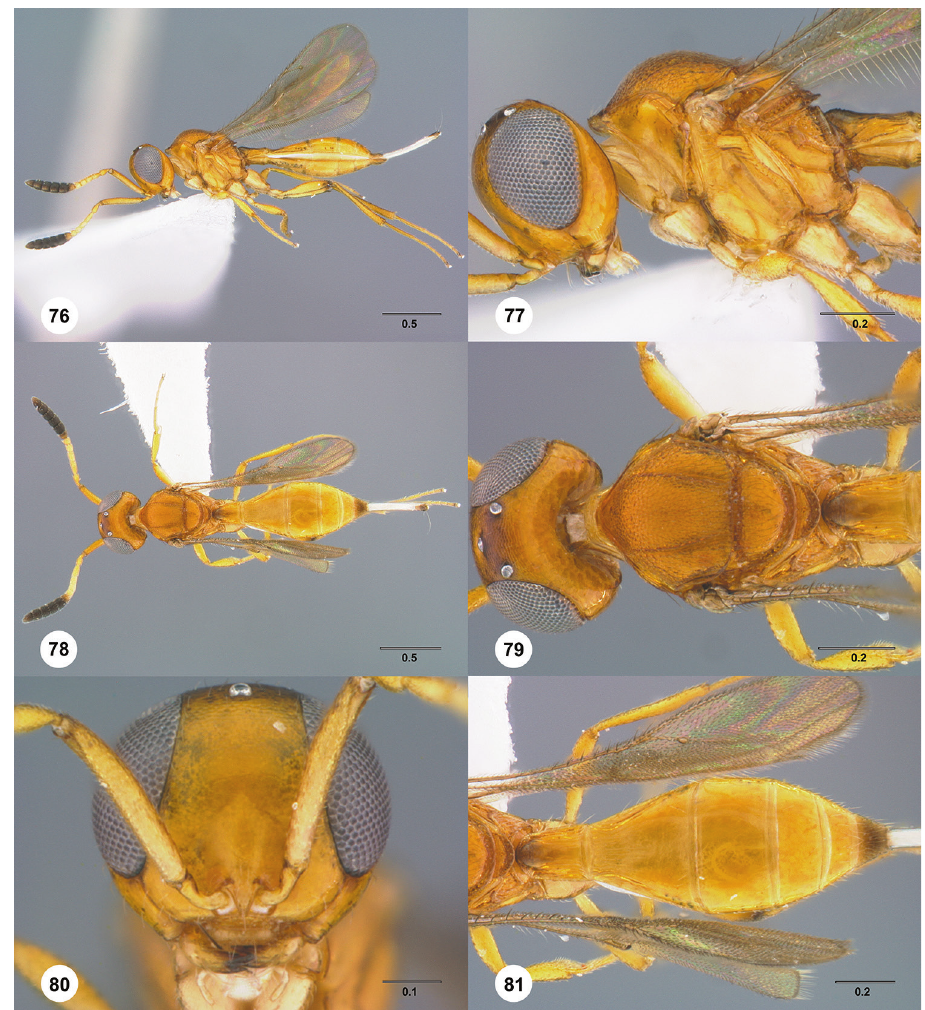
Figures 76–81. Calliscelio carinigena sp. n., female, holotype (OSUC 343907). 76 Lateral habitus 77 Head and mesosoma, lateral view 78 Dorsal habitus 79 Head and mesosoma, dorsal view 80 Head, anterior view 81 Metasoma, dorsal view. Scale bars in millimeters. of metascutellum in female: rugose. Sculpture of metascutellum in male: rugose. Dor- sal propodeum in female: shallowly excavate medially, with lateral propodeal carinae widely separated. Sculpture of dorsal propodeum in female: rugose. Sculpture of dorsal propodeum in male: rugose. Median keels on propodeum in female: absent. Meso- pleural carina: present. Sculpture of mesepisternum below mesopleural depression: smooth. Sculpture of ventral metapleural area: largely smooth, rugose ventrally. Color of legs: orange throughout; pale yellow throughout. Sculpture of hind coxa: